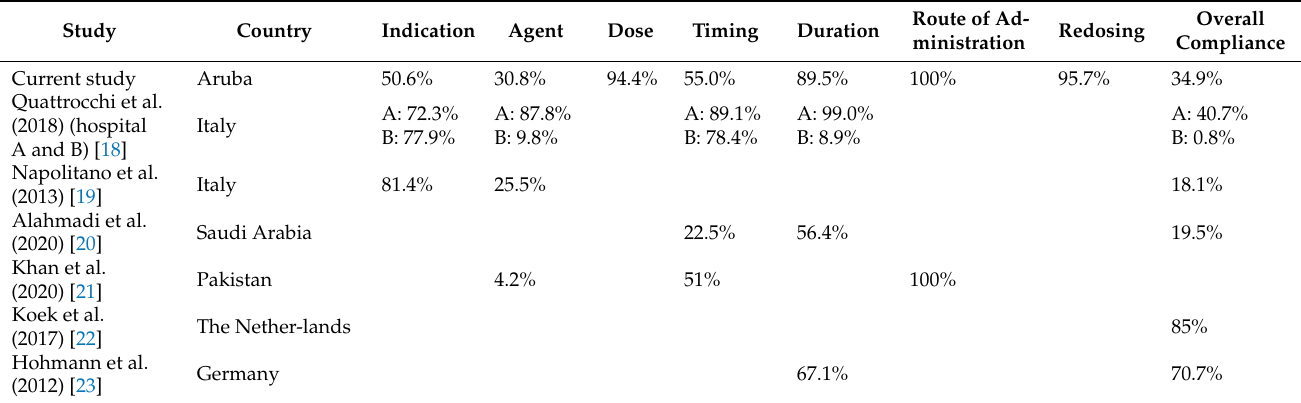
Table 5. Compliance rates to local guidelines in multiple countries